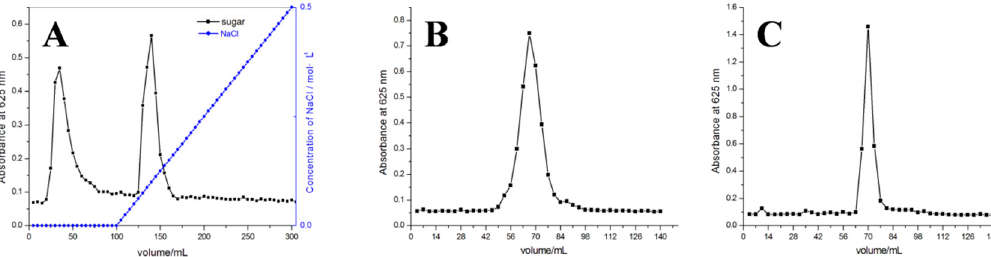
Figure 1. DEAE-FF and S-400 HR elution curves of the AMEPs: ( A ) DEAE-FF elution curves of the AMEP; ( B ) S-400 HR elution curves of the AMEP-1; and ( C ) S-400 HR elution curves of the AMEP-2.